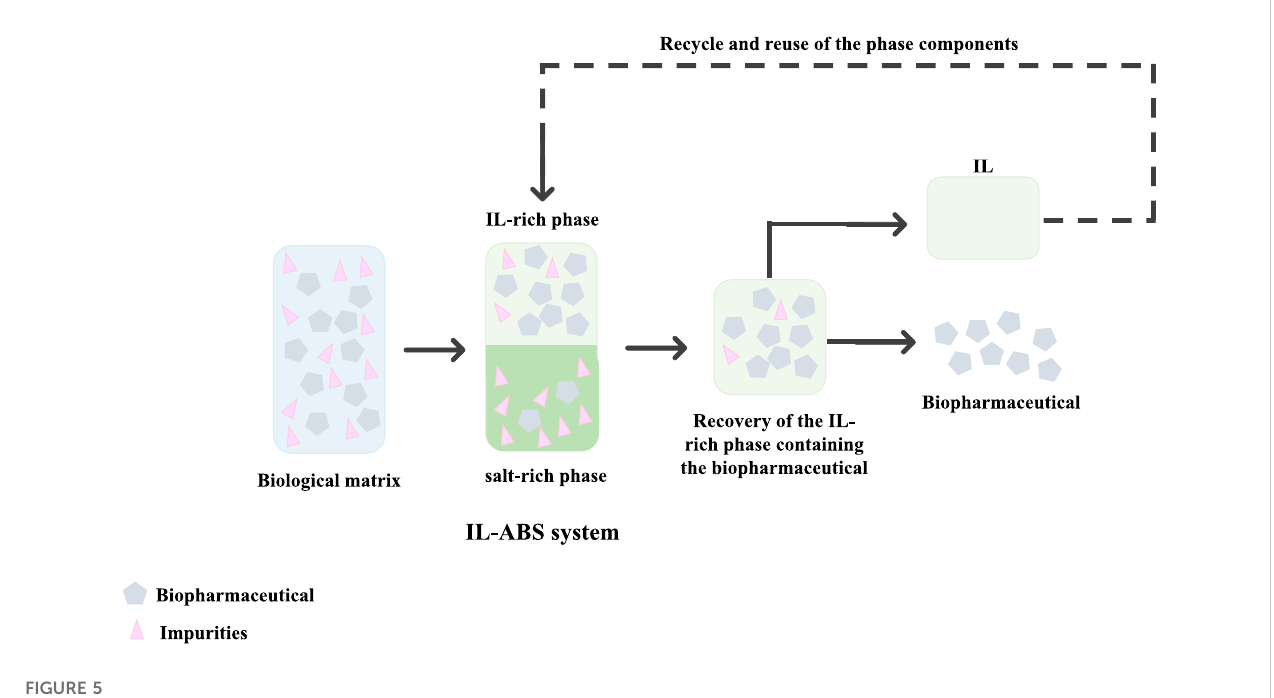
FIGURE 5 Overview of a representative liquid-liquid extraction process using IL-ABS for the recovery and puri fi cation of biopharmaceuticals.